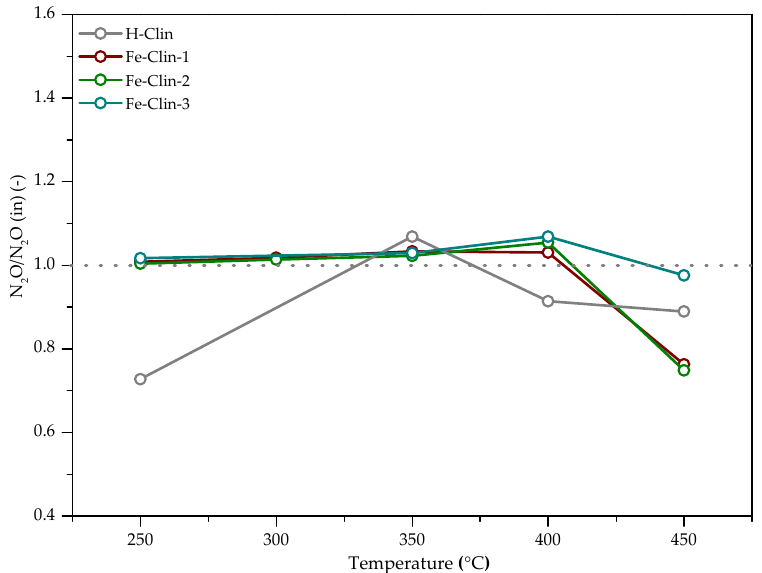
Figure 9. The ratio of N 2 O concentration downstream of the catalytic bed and N 2 O inlet concentration as a function of the temperature for H-Clin, Fe-Clin-1, Fe-Clin-2, Fe-Clin-3 at GHSV = 9000 h − 1 .